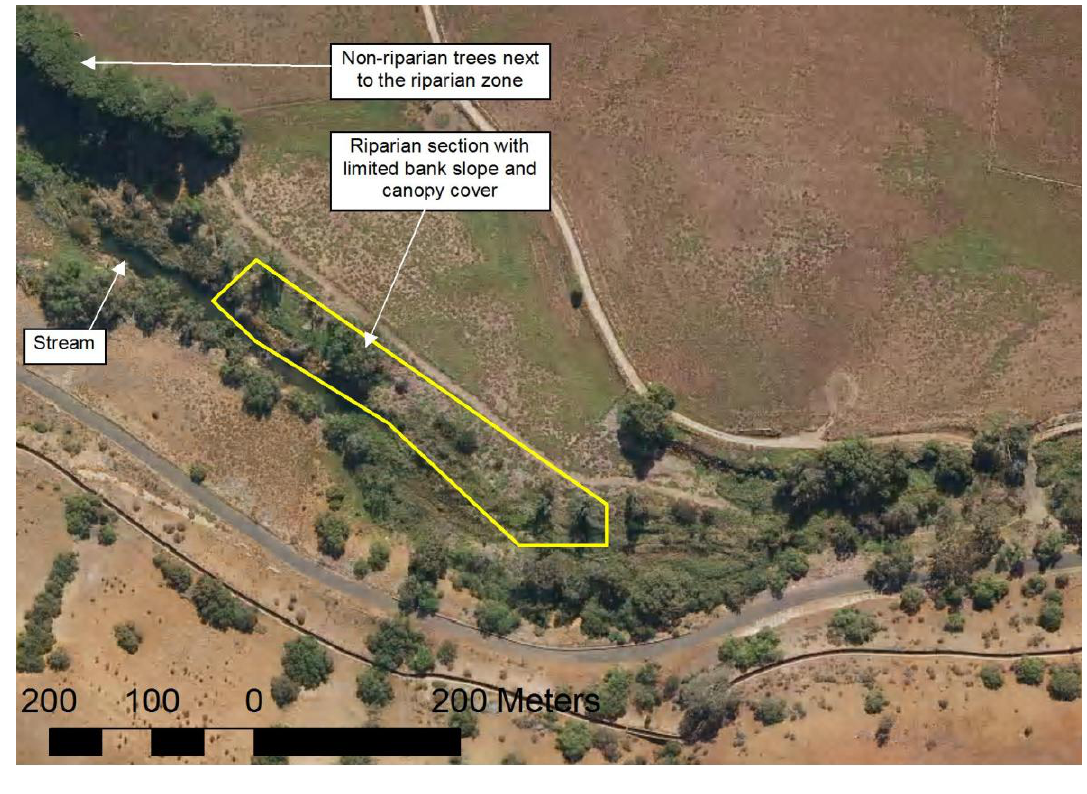
Figure 9. Example of riparian zone section (outlined in yellow) with very limited bank slope and canopy cover, which caused underestimation of riparian zone width in some areas. Non-riparian trees next to the riparian zone caused overestimation of riparian zone width. UltracamD image data used for